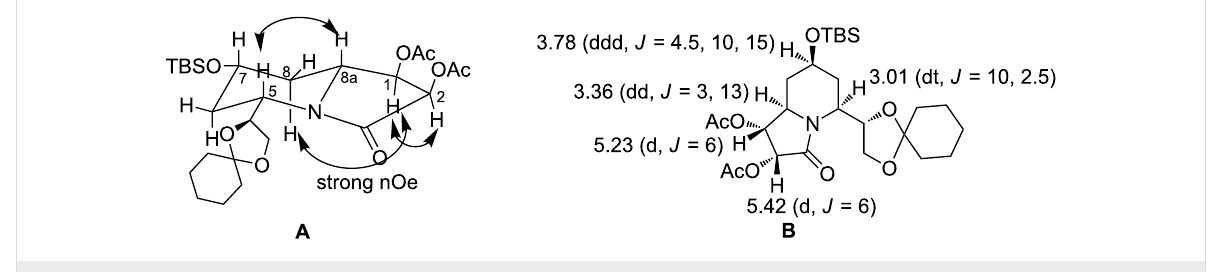
Figure 3: Selected nOe correlations (A) and coupling constants (B) for compound 15 .